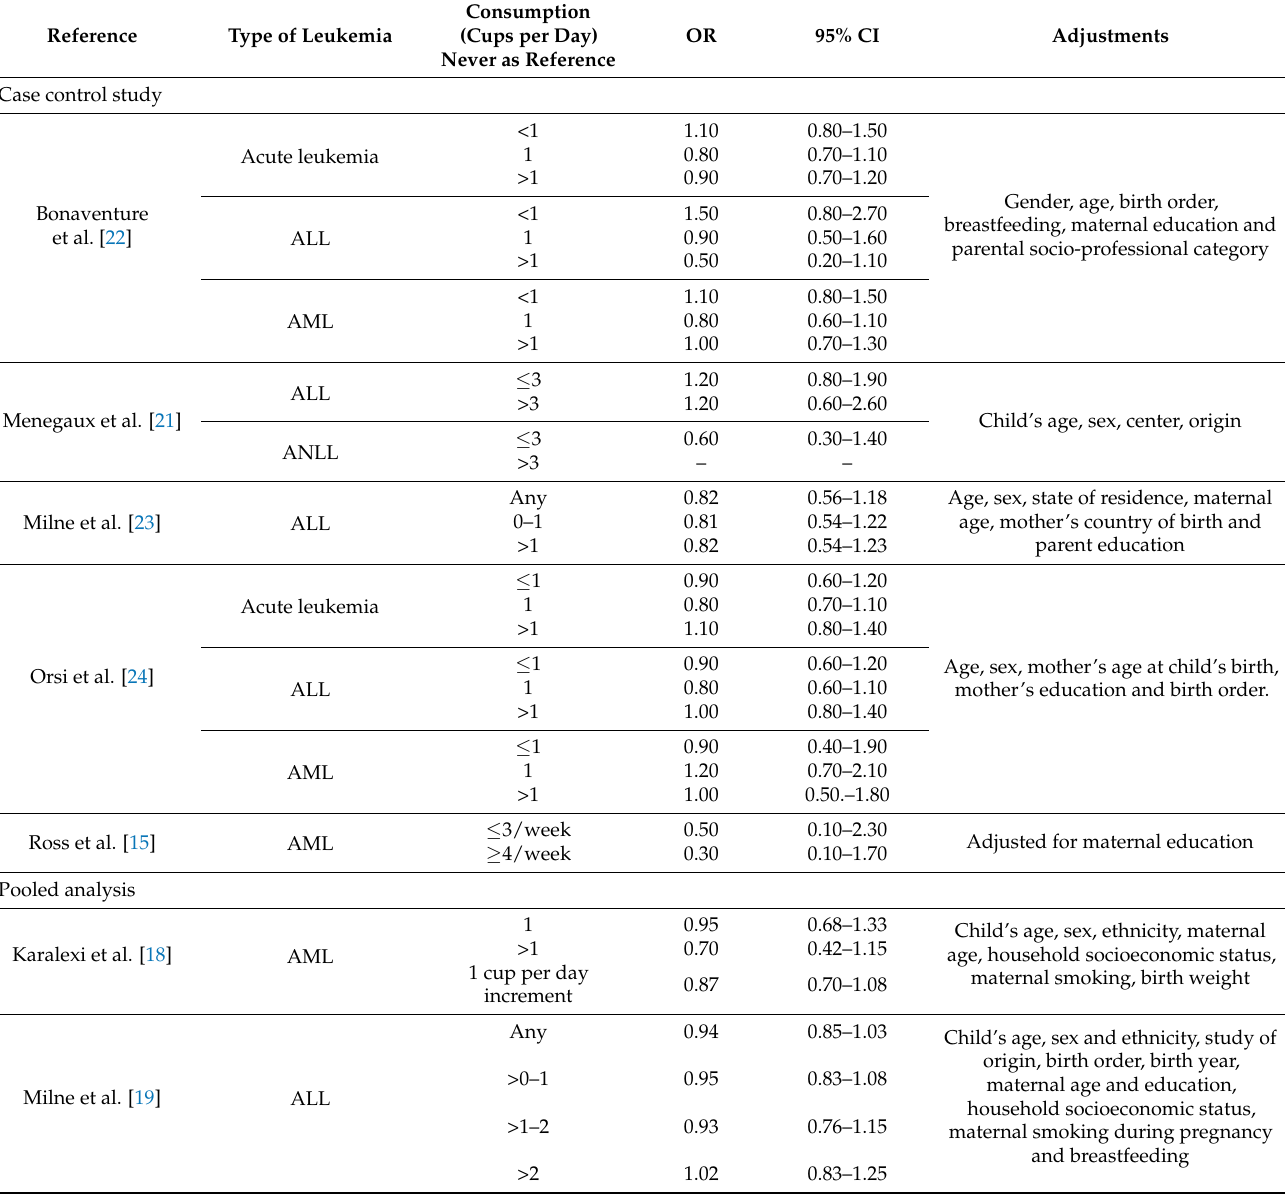
Table 7. Overview of the association between maternal tea consumption during pregnancy and risk of acute leukemia in children.